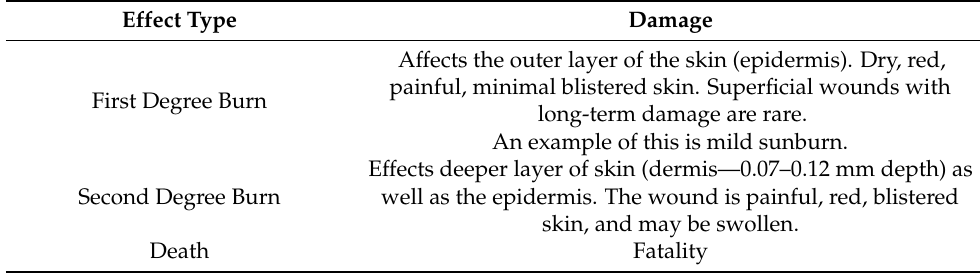
Table 2. Thermal radiation consequence description [19].